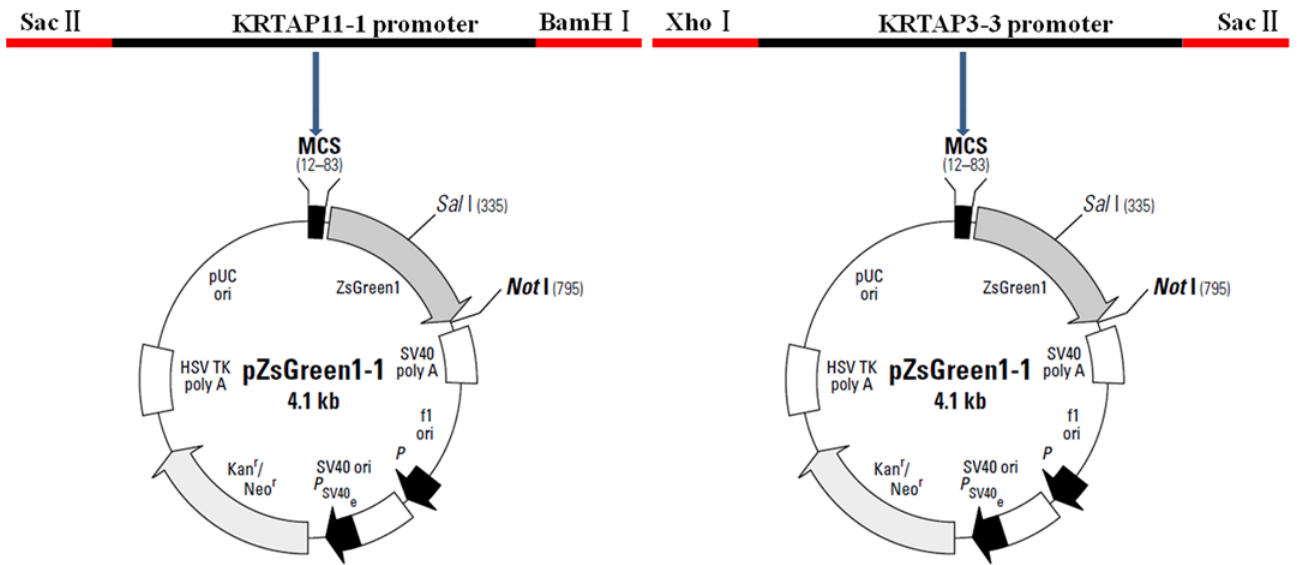
Fig 3. Structure diagram of the KRTAP11-1-ZsGreen1 and KRTAP3-3-ZsGreen1